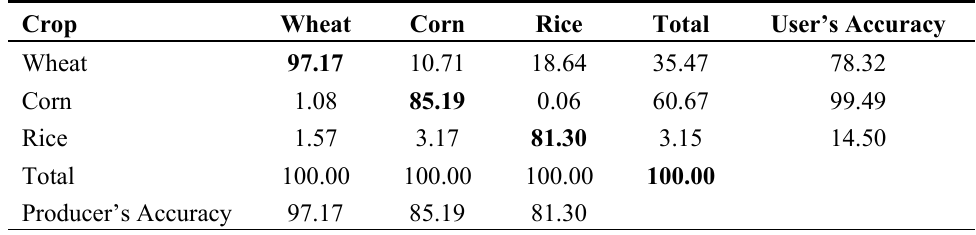
Table 6. Contingency table of 2000 LULC of agricultural land from a single Landsat scene (Path 133 Row